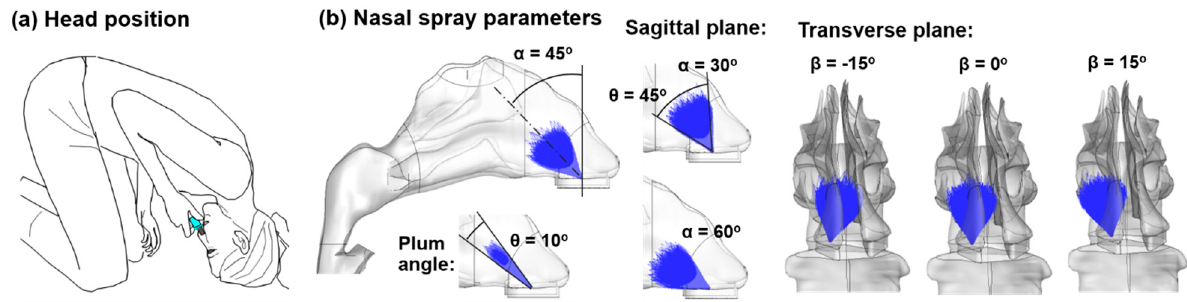
Figure 2. Nasal spray administration: ( a ) vertex-to-floor position and ( b ) different application angles ( α , β ) and spray plume angles ( θ ). The spray application angle relative to the nostril has two degrees of freedom: α in the sagittal plane and β in the transverse plane.